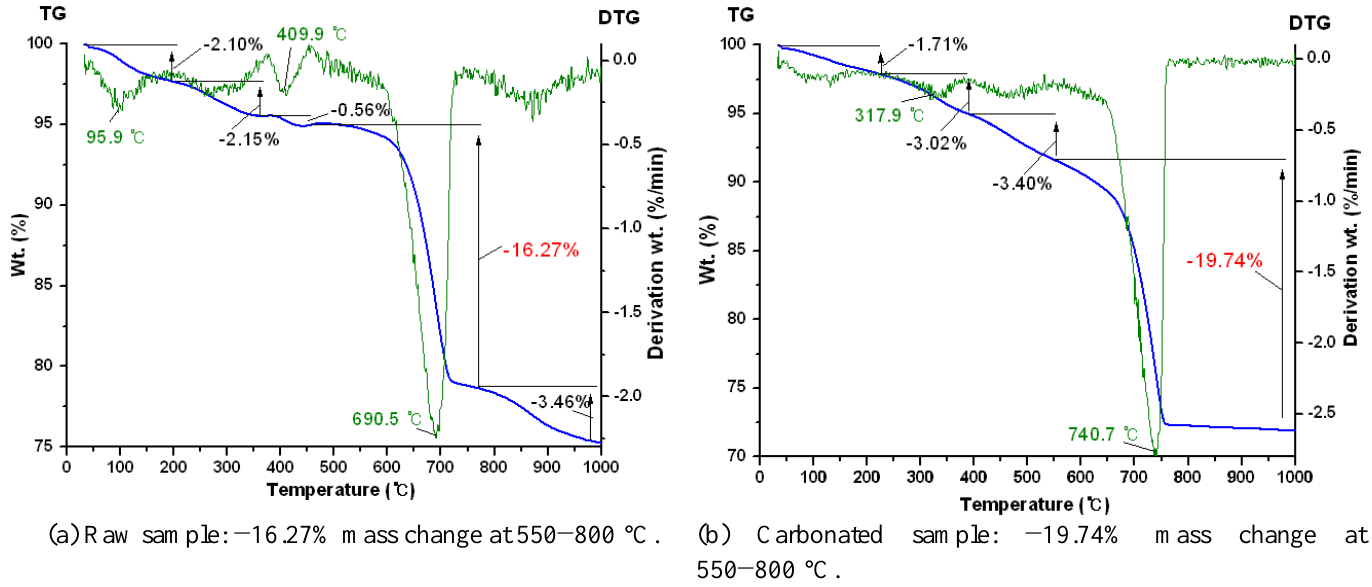
Figure 19. Quantitative evaluation of CO in municipal solid waste incineration (MSWI) 2 bottom ash before (a) and after accelerated carbonation (b), using TG/DTG analysis at various temperatures (TG = thermo-gravimetric; DTG = derivative thermo-gravimetric) (Unpublished graphs).